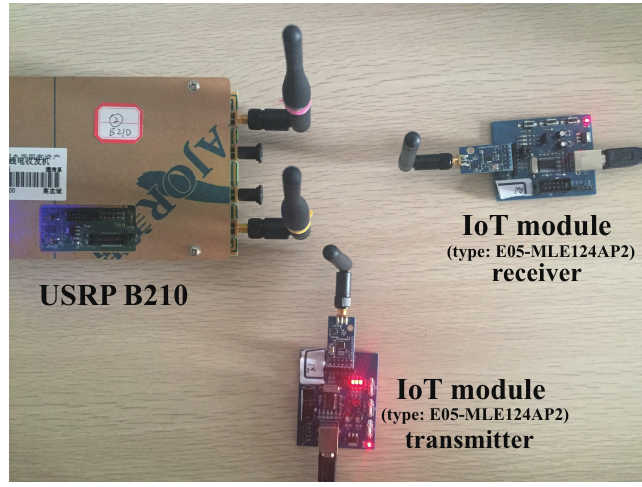
Figure 12. Experimental equipment.